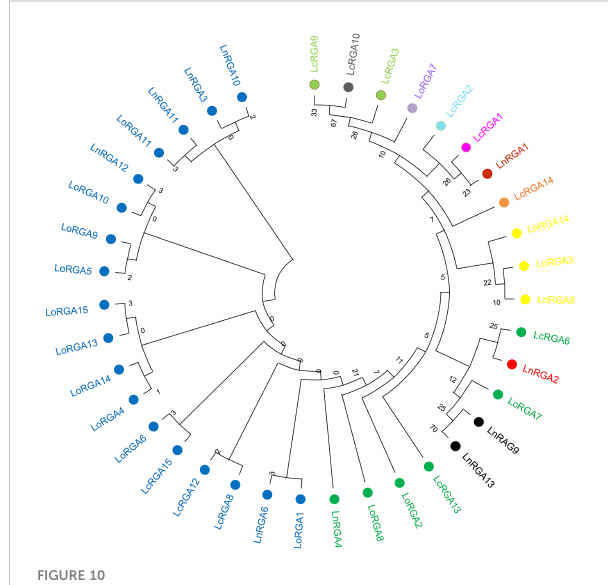
FIGURE 10 Phylogenetic tree constructed based on amino acid corresponding to active binding sites (ABS) using maximum likelihood in MEGA X with 1000 bootstrap replication. Lentil RGAs with the same color represent having a similar ABS. Blue represents GTDN, green represents GTD, black represents GTDG, red represents GTDT, yellow represents GTDL, orange represents GT, red represents L, pink represents GTS, light blue represents SN, purple represents G, light green represents GTNS, and gray represents